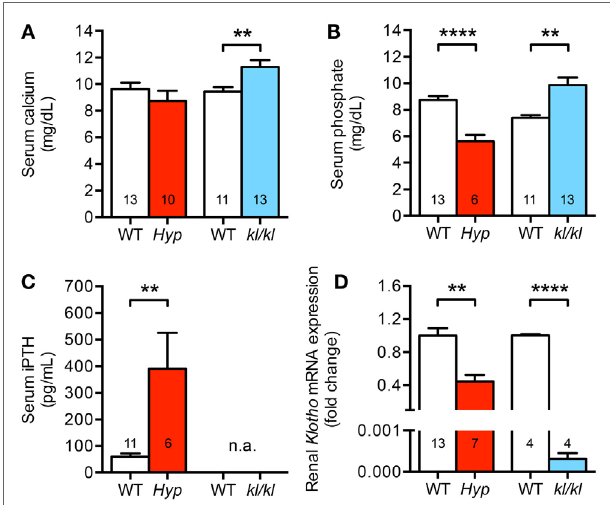
FigUre 6 | Different mineral metabolism between Hyp and kl/kl mice. (a) Serum calcium levels are normal to slightly reduced in Hyp mice and elevated in kl/kl animals. (b) Hyp mice are hypophosphatemic and kl/kl mice display hyperphosphatemia. (c) Serum parathyroid hormone (PTH) levels in Hyp mice are extensively elevated. For kl/kl mice, the PTH levels in the serum were not available (n.a.). (D) Renal Klotho mRNA expression is reduced in Hyp mice than in respective wild-type mice and barely detectable in kl/kl mice. Values are presented as mean ± SEM; numbers in each bar graph represent the n- values used for the respective measurement; ** P < 0.01, **** P <